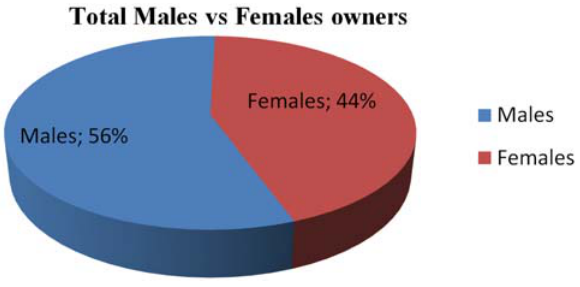
Fig. 1. Gender of sampled